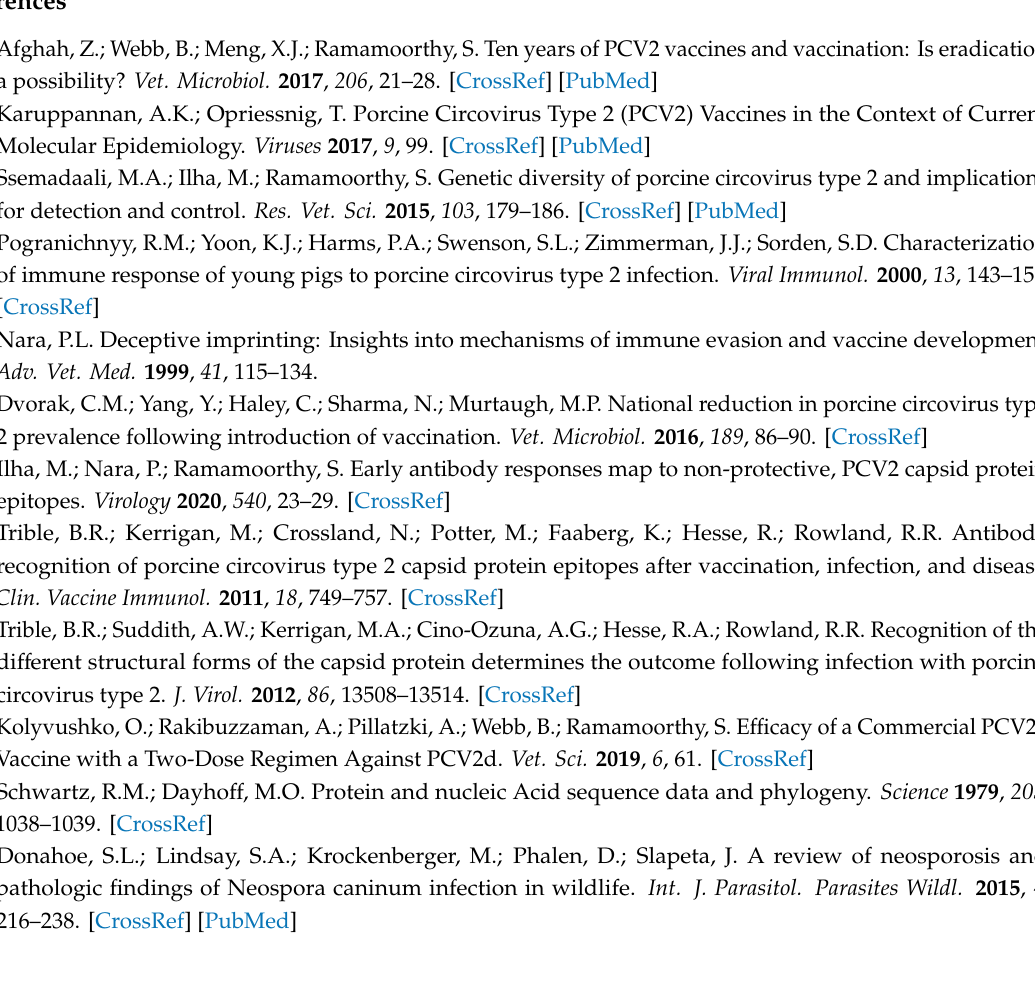
Figure S1: Multiple sequence alignment of the PCV2 capsid protein, Figure S2: Map of the rPCV2-Vac construct, Figure S3: Post-challenge weight gain, Table S1: Amino acid sequences of Epitope A and